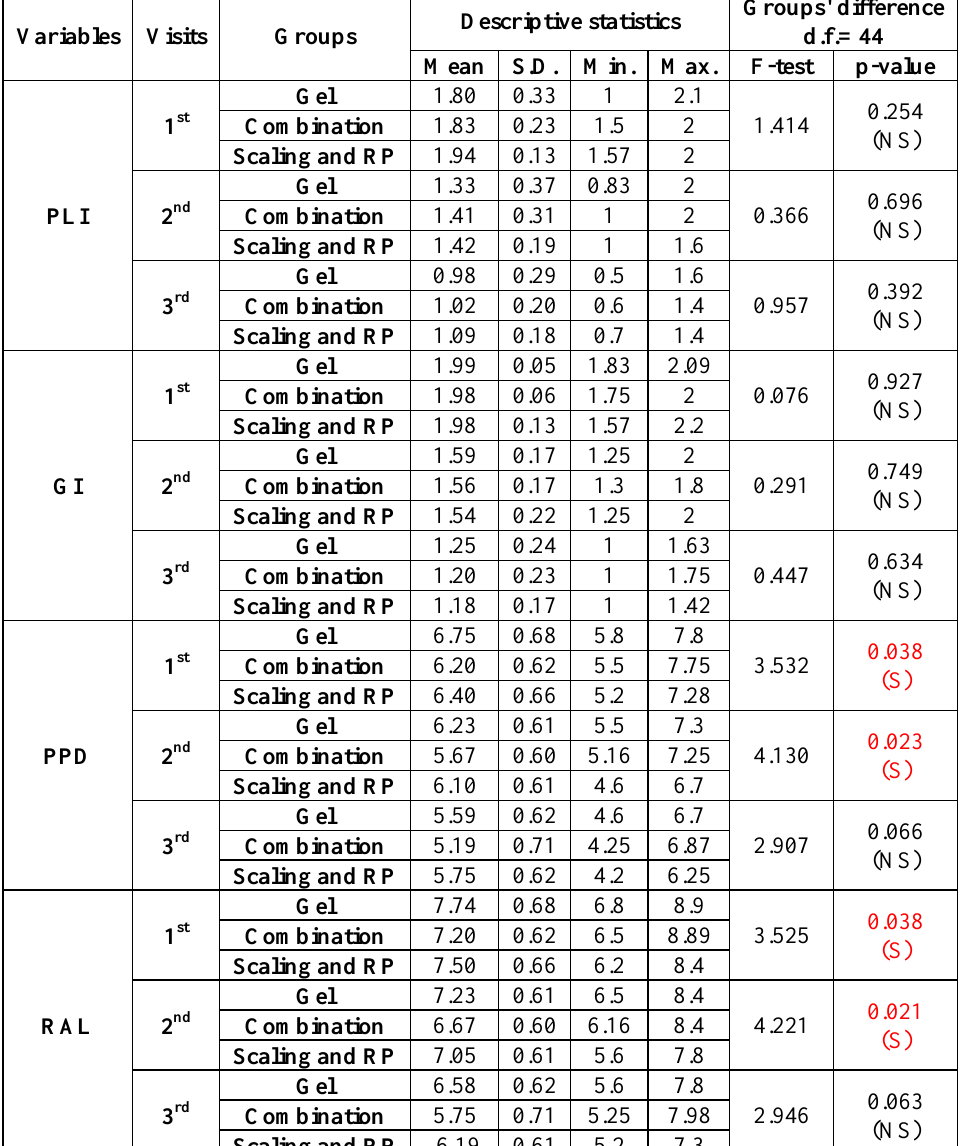
Table 1: Mean and Standard Deviation Values of the Clinical Periodontal Parameters (PLI, GI, PPD and RAL) in Inter-Groups Comparison among the Three Groups by ANOVA Test Descriptive statistics Variables Visits Groups